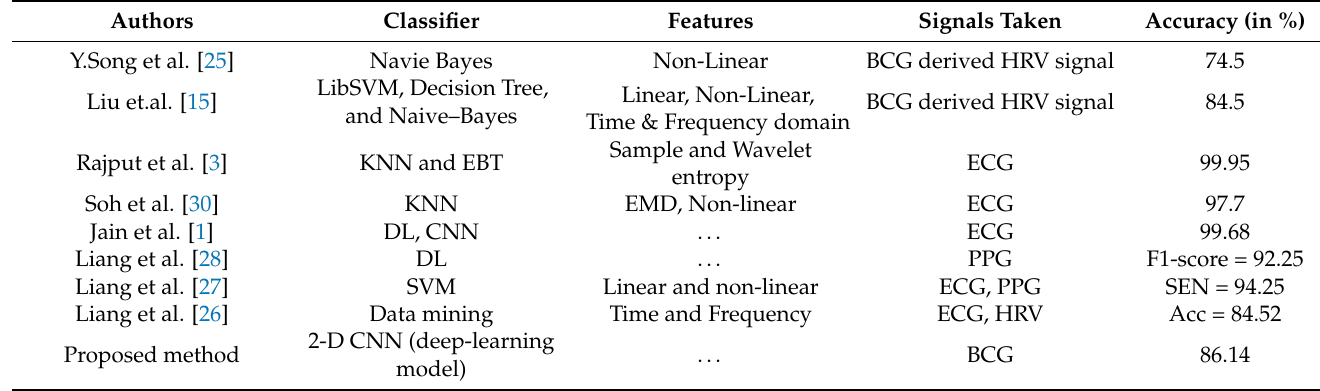
Table 6. Comparison of our results with existing state-of-the-art methods developed for automated HPT